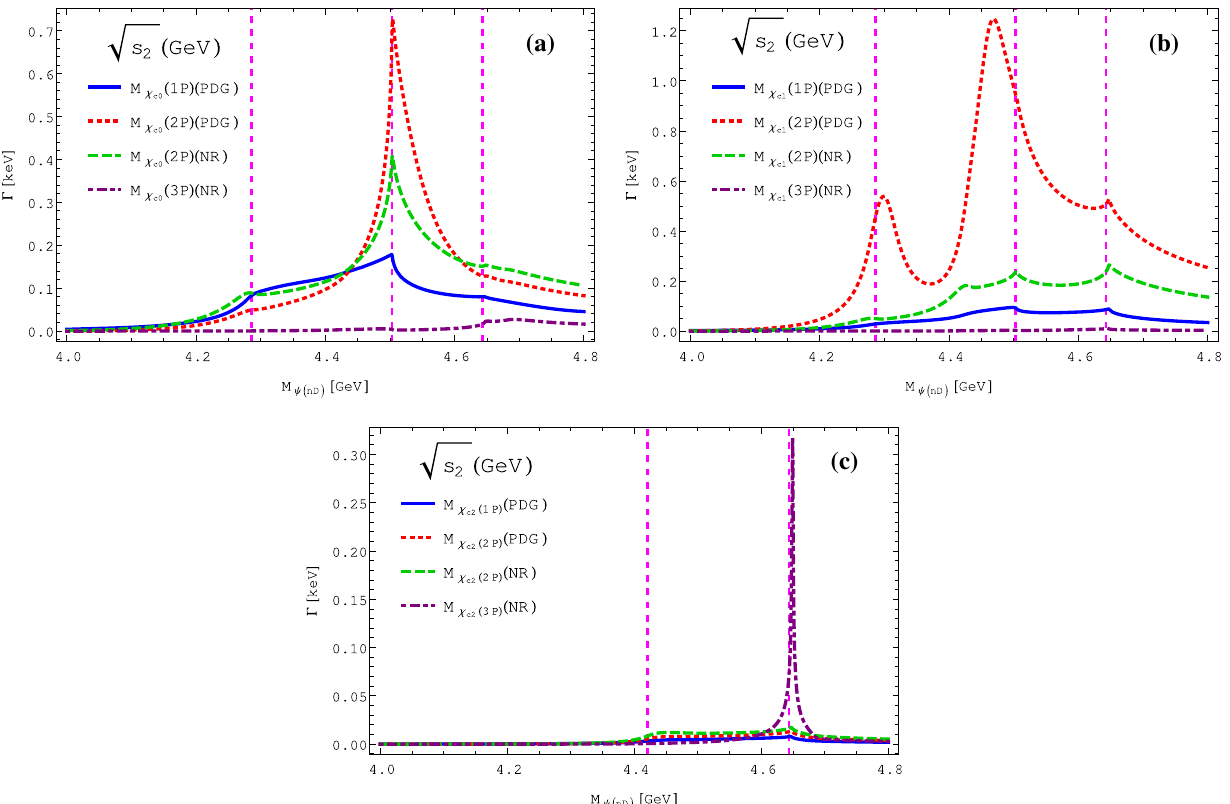
( 2420 ) ¯ D 0 threshold, 1